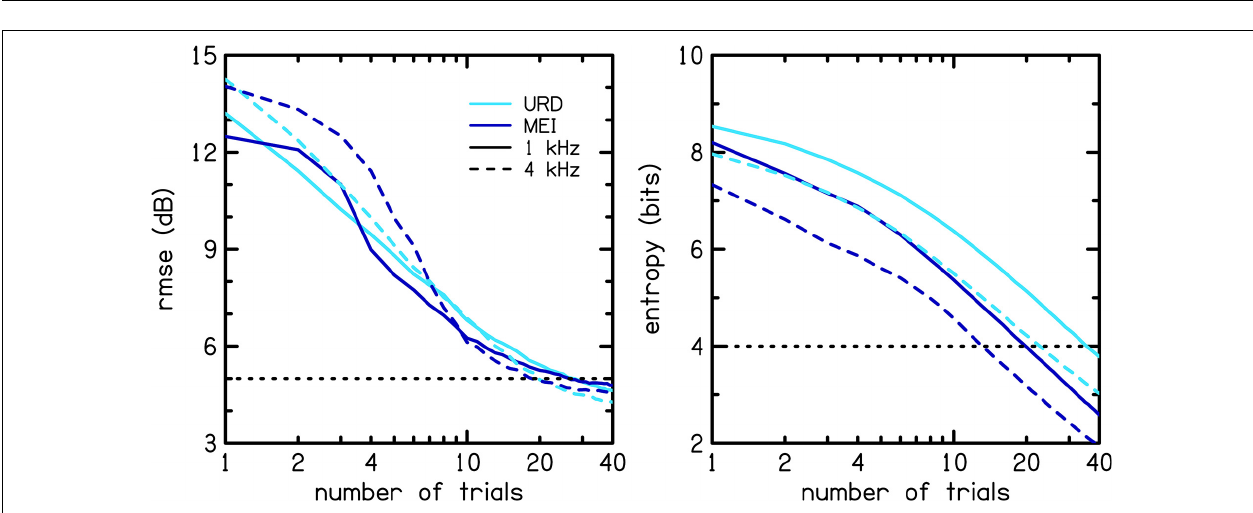
FIGURE 7 | Threshold differences between CLS thresholds and audiometric thresholds for each of the four CLS procedures. The difference in threshold was calculated by subtracting the audiometric threshold from the CLS threshold. Symbols represent the mean difference and error bars represent one standard deviation.